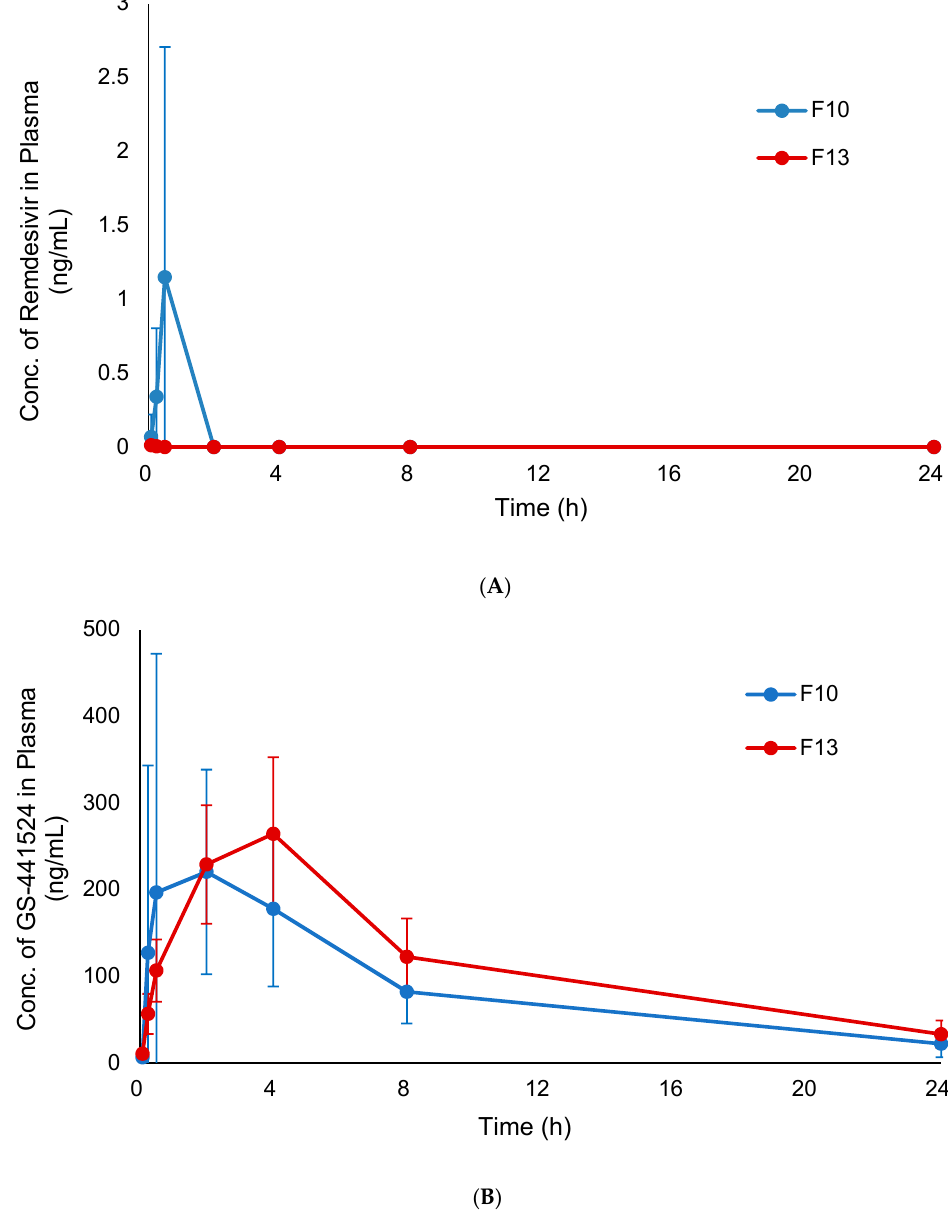
Figure 9. Plasma concentration-time profiles of F10 (remdesivir-Captisol ® ; 80 / 20 w / w ) and F13 (remdesivir-leucine; 80 / 20 w / w ) after a single inhalation administration in rats; ( A ) remdesivir; ( B ) GS-441524. Table 4. In vivo pharmacokinetic parameters for the plasma GS-441524 concentrations of F10 and F13 following a single inhalation administration.